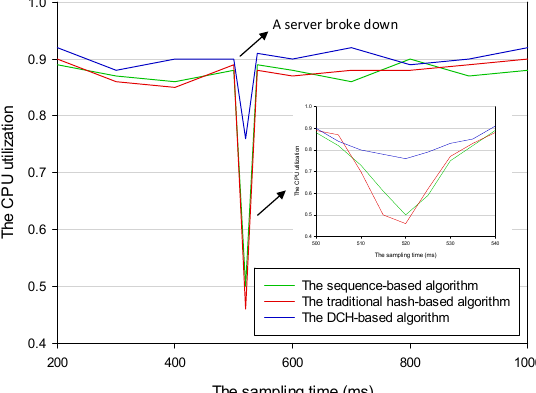
Figure 17. The CPU utilization of the Internet of Things (IoT) system based on different deploying algorithms.